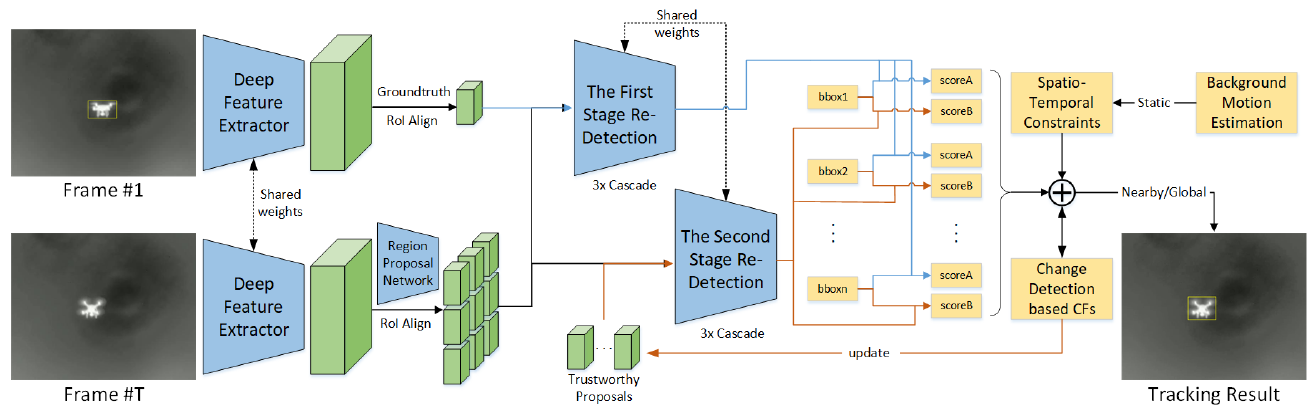
Figure 1. Overall architecture of SiamSTA. It consists of a Siamese backbone that extracts deep features from the template and the search image, followed by a three-stage re-detector that first re-detects the first-frame template, then re-locates historical predictions from previous frames, and finally fixes potential tracking failures using a change detection based CF. The symbol (cid:76) indicates an ensemble classifier that conditionally switches between local track and global detection to make optimal decisions upon predictions from the three-stage